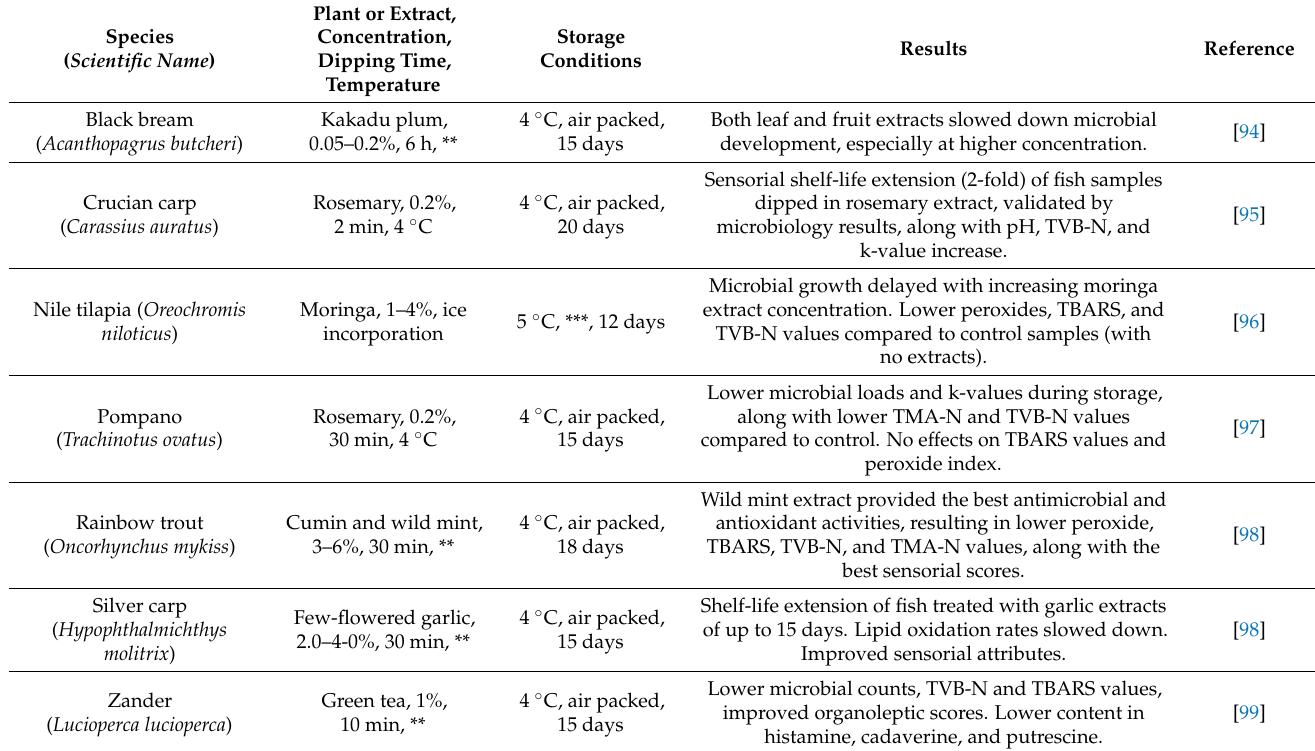
Table 5. Examples of the application of natural extracts from plants to fresh fish and their effects on fish quality